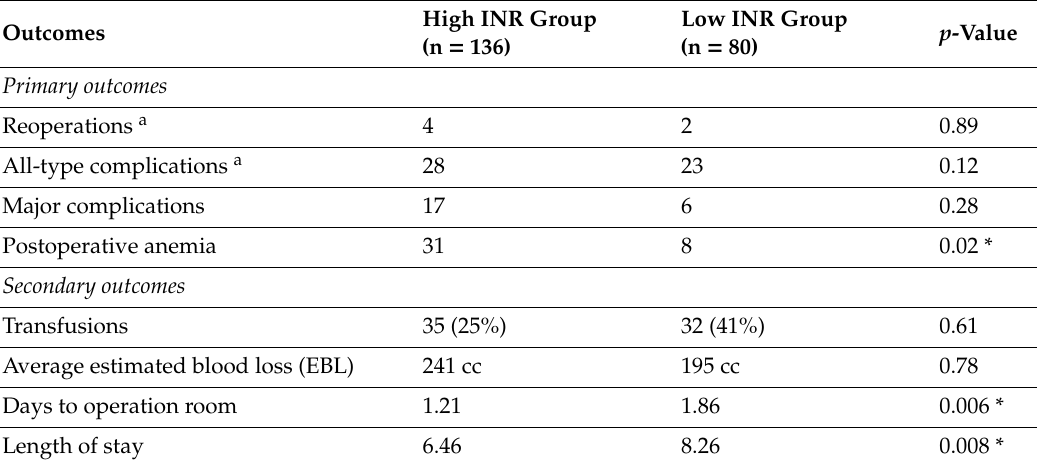
Table 1. Outcomes of surgical interventions on hip fracture patients (N =